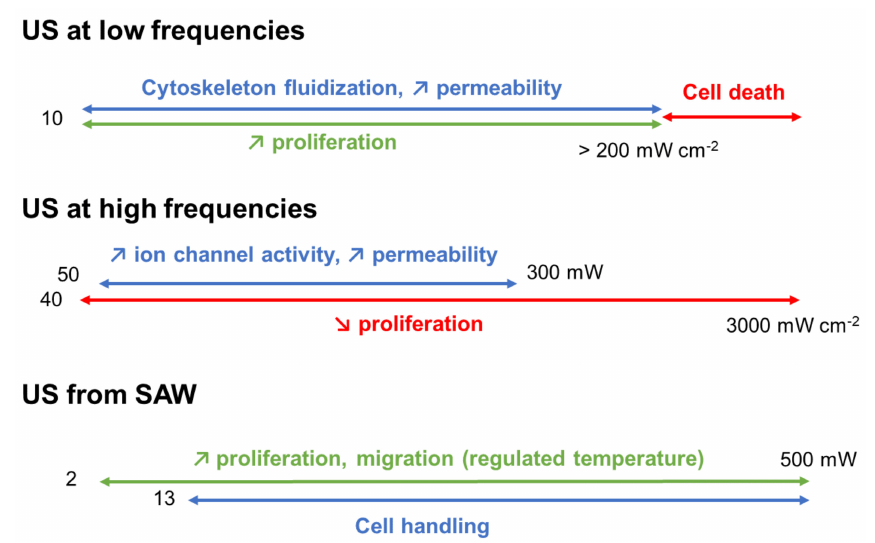
Figure 6. Sum up of the global tendencies of US effects on human and mammalian cells. Red: deleterious effects, blue: effects on the cytoskeleton and cell membrane, green: favorable